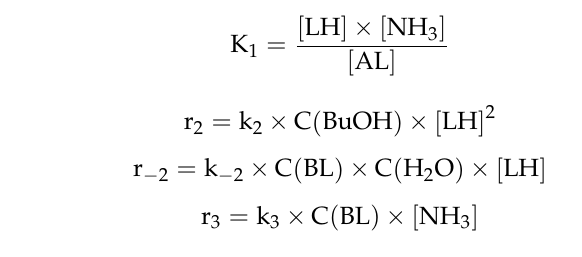
Figure 4. Dependence between the experimental and calculated concentrations of lactic acid: C(LH)exp—the lactic acid concentrations obtained experimentally, and C(LH)calc—lactic acid con- centrations calculated using the kinetic model.